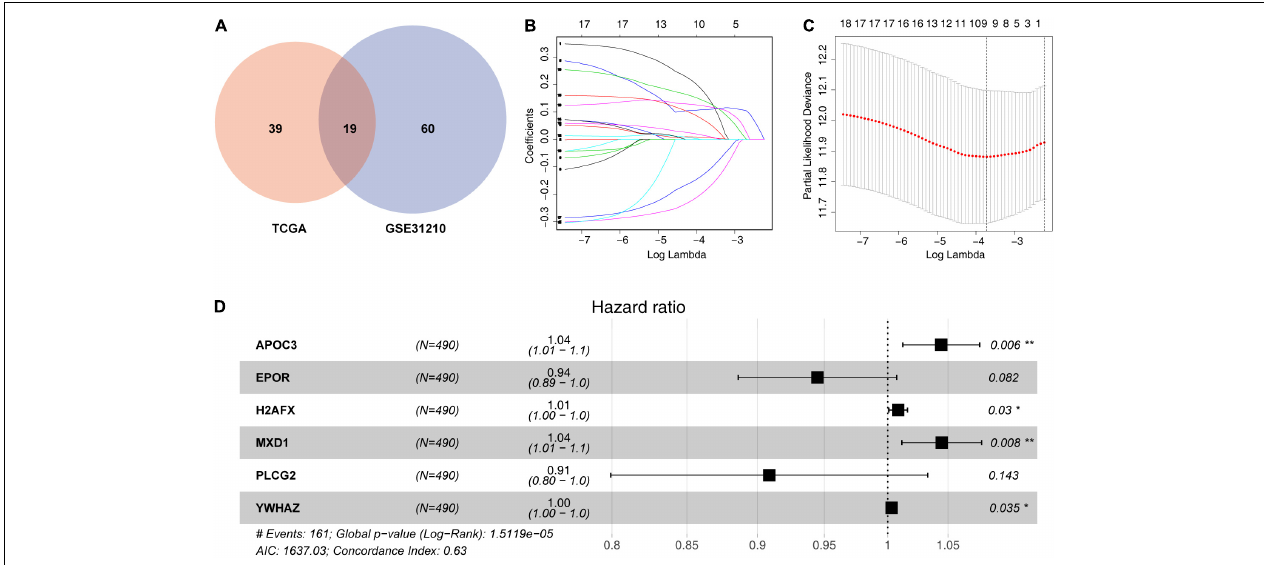
FIGURE 1 | Identification of a prognosis-related ARG-based signature. (A) Nineteen overlapping prognostic ARGs based on TCGA and GSE31210. (B) Selection of the optimal parameter (lambda) in the least absolute shrinkage and selection operator (LASSO) model; dotted vertical lines were drawn at the optimal values using the minimum criteria. (C) LASSO coefficient profiles of the 19 prognosis-associated ARGs with non-zero coefficients determined by the optimal lambda. (D) Multivariate Cox regression analysis screened six ARGs ( APOC3 , EPOR , H2AFX , MXD1 , PLCG2 , and YWHAZ ) to construct a risk signature. * P < 0 . 05 and ** P < 0 .